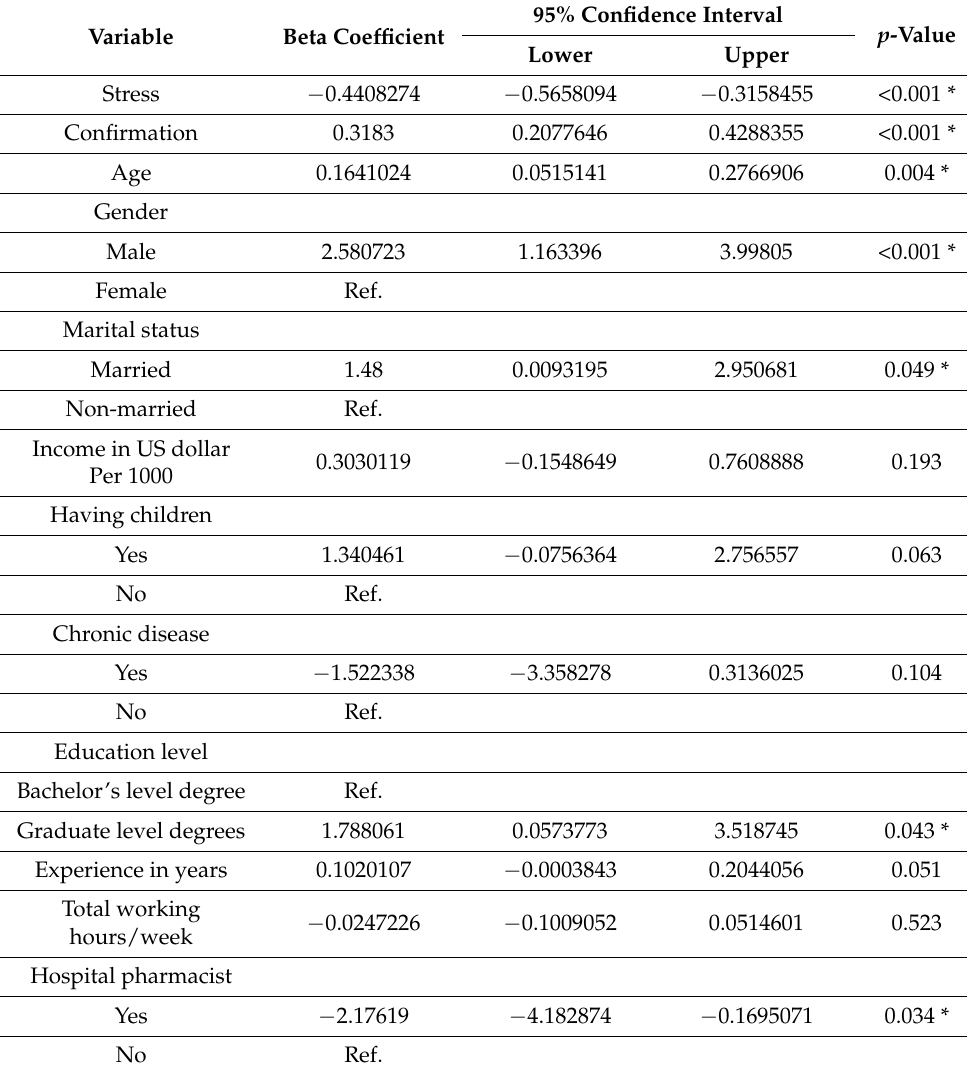
Table 3. Univariate linear regression analysis of predictors associated with pharmacists’ job satisfac- tion in Saudi